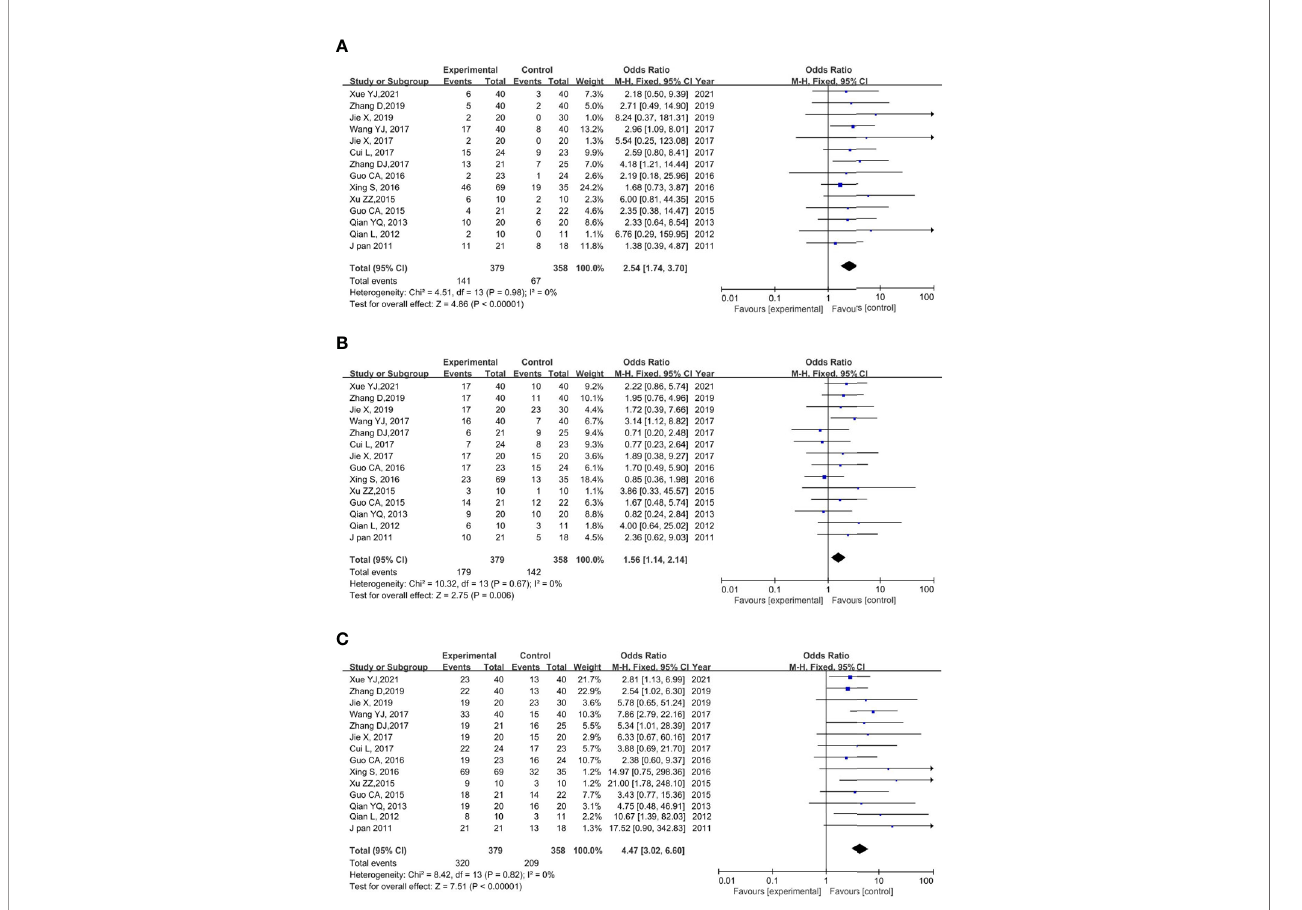
FIGURE 4 | Forest plot for CR (A) , PR (B) , and ORR (C) of rAd-p53 combined CT/RT/CRT group and CT/RT/CRT alone group. CR: complete remission; PR, partial remission; ORR, objective tumor response rate; CT, chemotherapy; RT, radiotherapy; CRT, chemoradiation therapy.